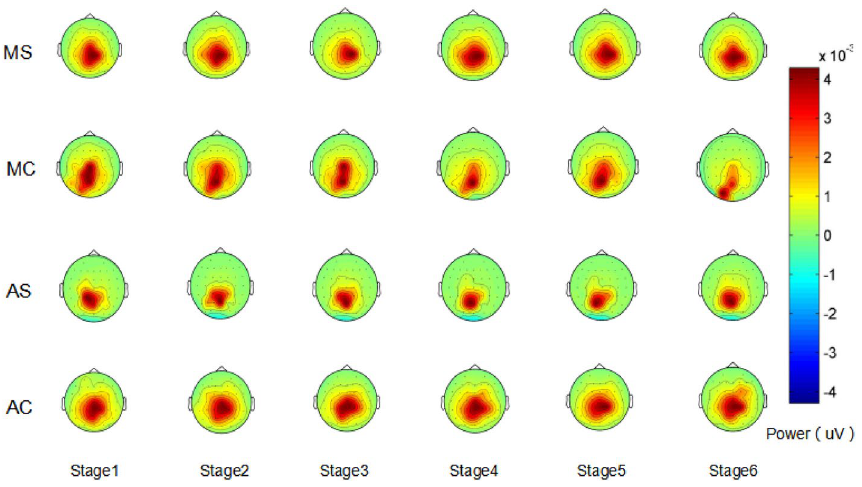
Figure 6. EEG alpha wave band brain